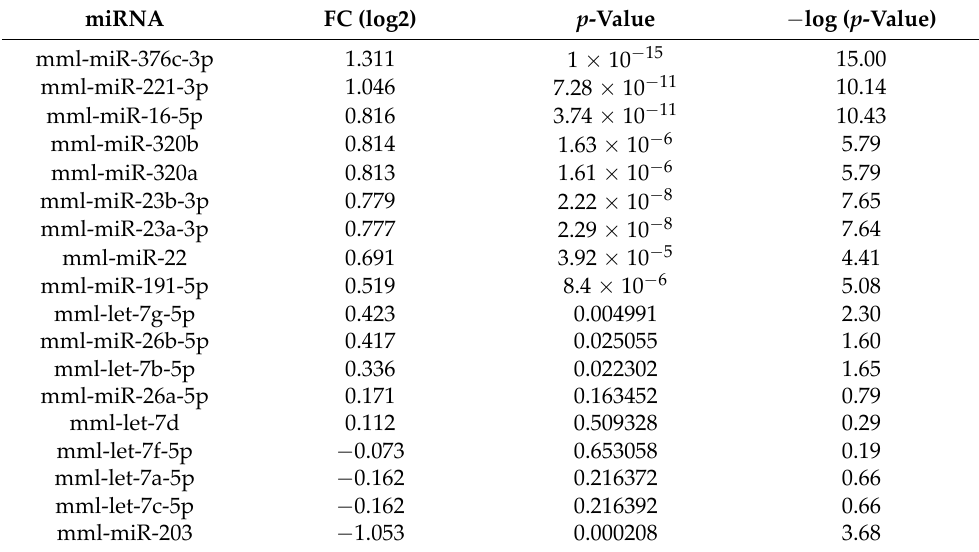
( E ) Visualization of miRNA‑target interaction network for the 1 unique EV‑associated miRNA. ( F ) miRNA‑target enrichment analysis showing top target genes by number of interactions for the top 10 unique EC‑associated miRNAs. ( G ) Visualization of miRNA‑target interaction network for the top 10 unique EC‑associated miRNAs. ( H ) Dot plot of functional enrichment analysis for the top 10 unique EC‑associated miRNAs. Color of dots represents adjusted p ‑values (FDR), and size of dots represents gene ratio (number of miRNA targets found enriched in each category/number of total genes associated with that category). ( I ) PCA plot of the 18 (arrow from panel ( A )) common EV and EC miRNAs. Unit variance scaling is applied to rows; SVD with imputation is used to cal‑ culate principal components. X and Y axis show principal component 1 and principal component 2, which explain 74.4% and 19.1% of the total variance, respectively. Predication ellipses are such that with a probability of 0.95, a new observation from the same group will fall inside the ellipse. N = 15 data points. ( J ) Hierarchical clustering heatmap of the 18 common EV and EC miRNAs. Rows are centered; unit variance scaling is applied to rows. Both rows and columns are clustered using correla‑ tion distance and average linkage. ( K ) miRNA‑target enrichment analysis showing top target genes by number of interactions for the 18 common EV‑ and EC‑associated miRNAs. ( L ) Visualization of miRNA‑target interaction network for 18 common EV‑ and EC‑associated miRNAs. ( M ) Dot plot of functional enrichment analysis for target genes of 18 common EV‑ and EC‑associated miRNAs. Color of dots represents adjusted p ‑values (FDR), and size of dots represents gene ratio (number of miRNA targets found enriched in each category/number of total genes associated with that category. Table 3. List of 18 miRNAs associated with both EVs and